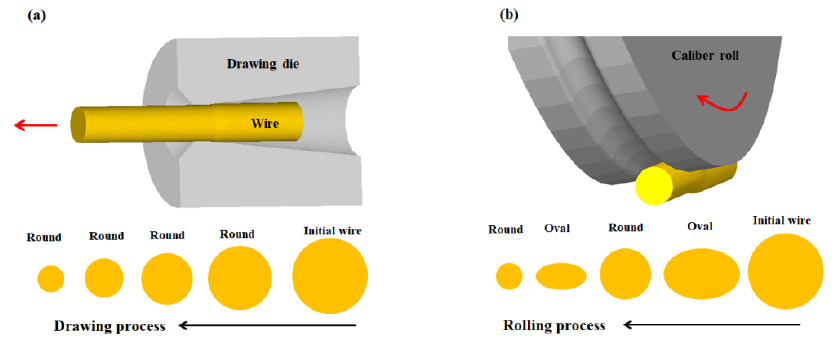
Figure 1. Schematic of ( a ) wire drawing and ( b ) caliber rolling processes used in this